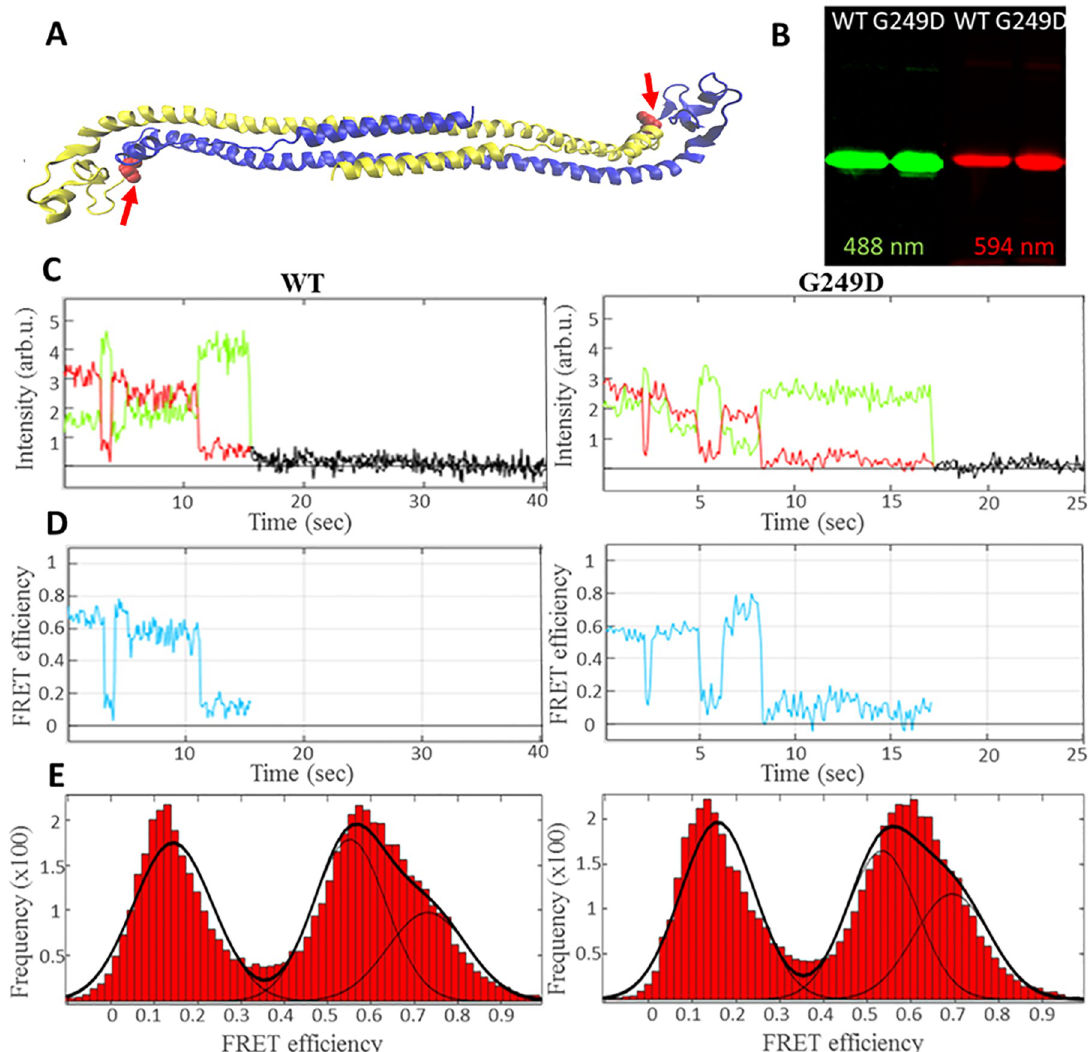
Fig 3. Three different conformational states are observed for human WT and G249D CCL2 dimers. Dually labelled human wt and G249D Trim5 α for sm-FRET measurements. (A) Cartoon representation of human wt CC-L2 dimers (yellow and blue) depicting location of fluorophore (Alexa 488 by green and Alexa 594 by red pentagon) conjugation and G249 residue (red arrows). (B) Gel electrophoresis of purified and dually labelled CC-L2 peptides imaged by using green (526 nm) or red (610 nm) emission filters. (C) Representative fluorescence intensity changes over time (donor shown in green, acceptor in red) obtained by TIRF microscopy for WT (left panel) and G249D (right panel) mutant respectively. (D) Calculated FRET efficiencies for CCL2 Dimers for WT (left panel) and G249D mutant (right panel) respectively. (E) Composite histogram of FRET efficiencies compiled from individual traces and fit to three Gaussian distributions for WT (left panel) and G249D mutant (right panel).